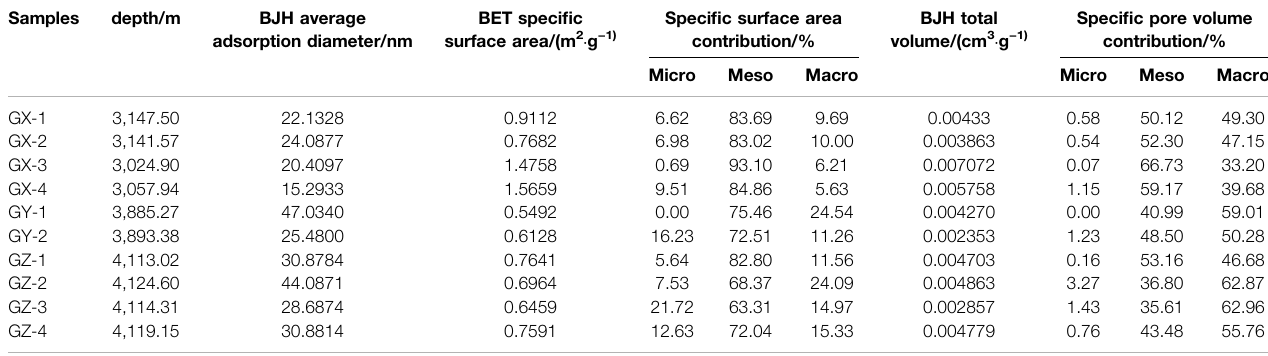
TABLE 2 | Contribution of micropore, mesopore, and macropore to total pore speci fi c surface area and volume of shale samples. Samples